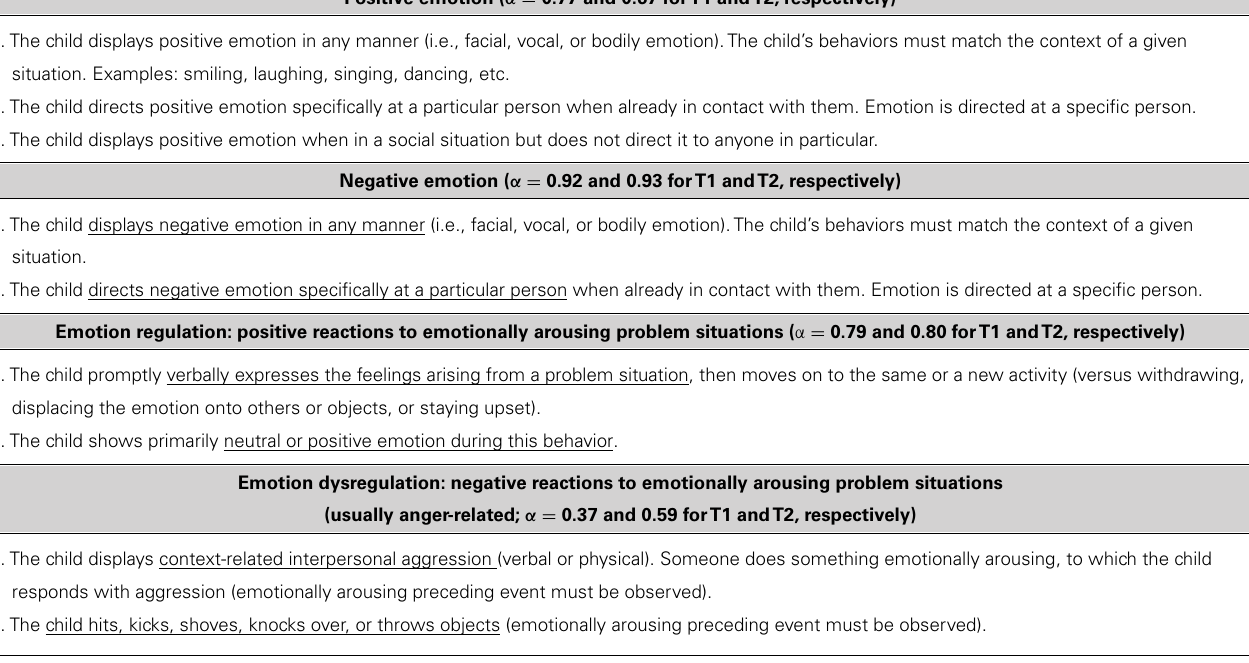
Table 1 | MPAC-R/S observation